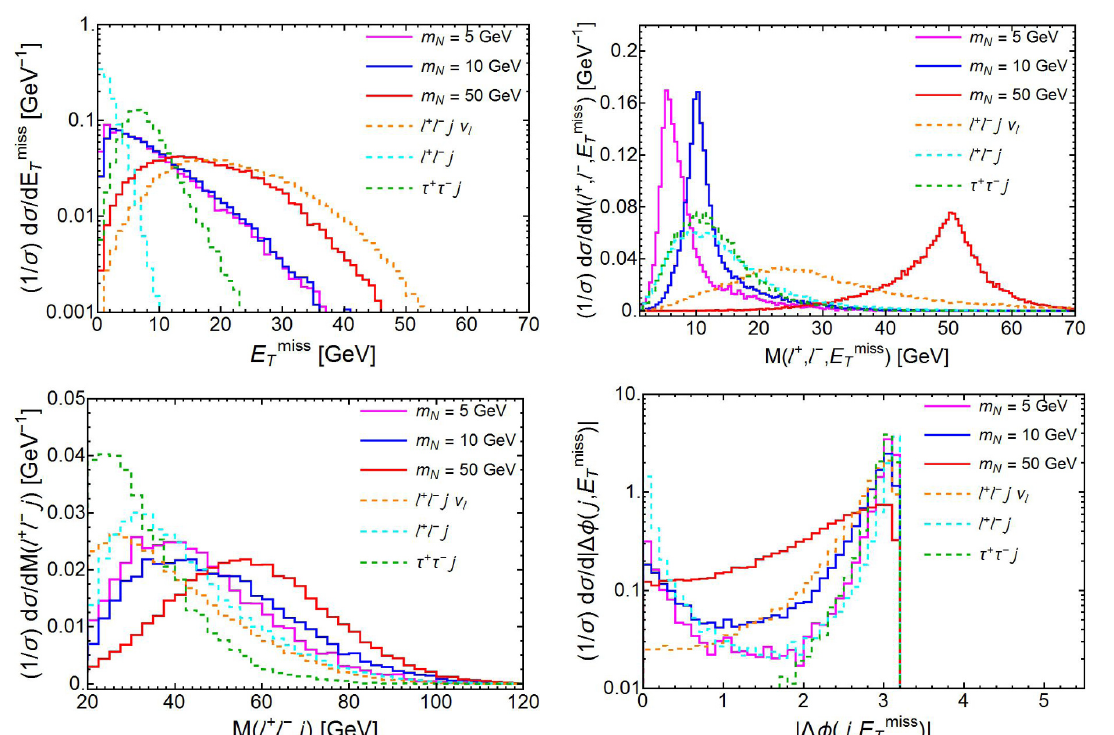
Figure 8 . Kinematic distributions of E miss (top left), M ( ‘ + , ‘ − , E miss ) (top right), M ‘‘j (bottom T T left), and | ∆ φ ( j, E miss ) | (bottom right) for signals with m N = 5 , 10 and 50 GeV and the three SM T backgrounds in the ‘ + ‘ − j + E miss ( ‘ = e, µ ) final state, after applying the isolation cuts of eq. (4.6). T